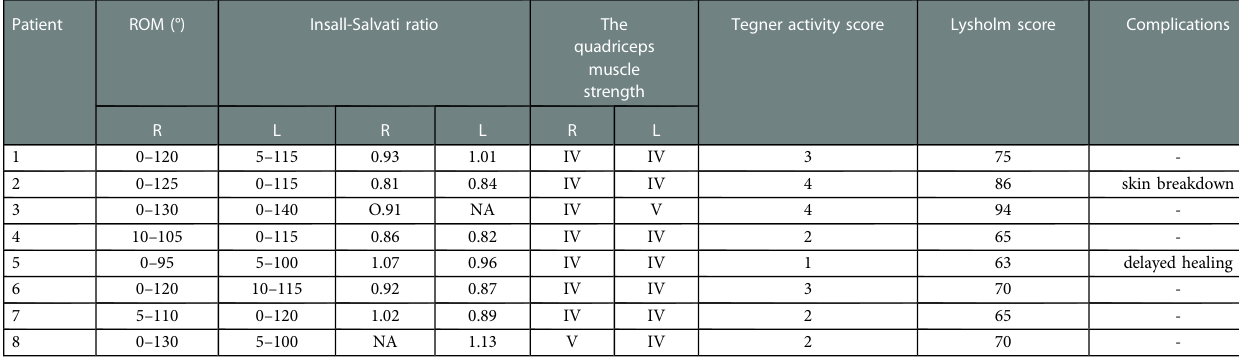
TABLE 4 Functional evaluation at the last follow-up. Patient